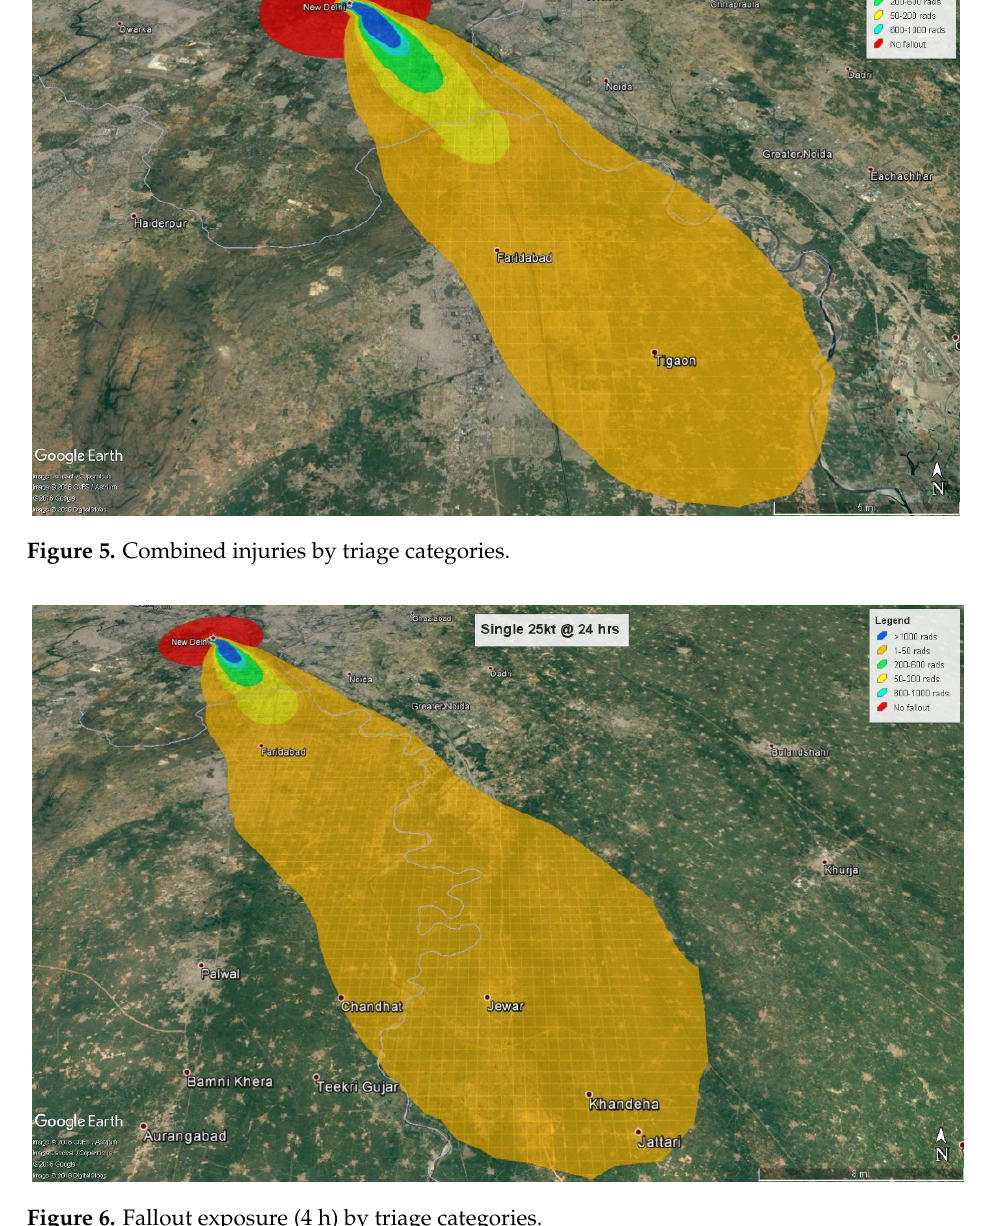
Table 6. Human casualties due to combined injuries (6 × 25 kt nuclear weapons).